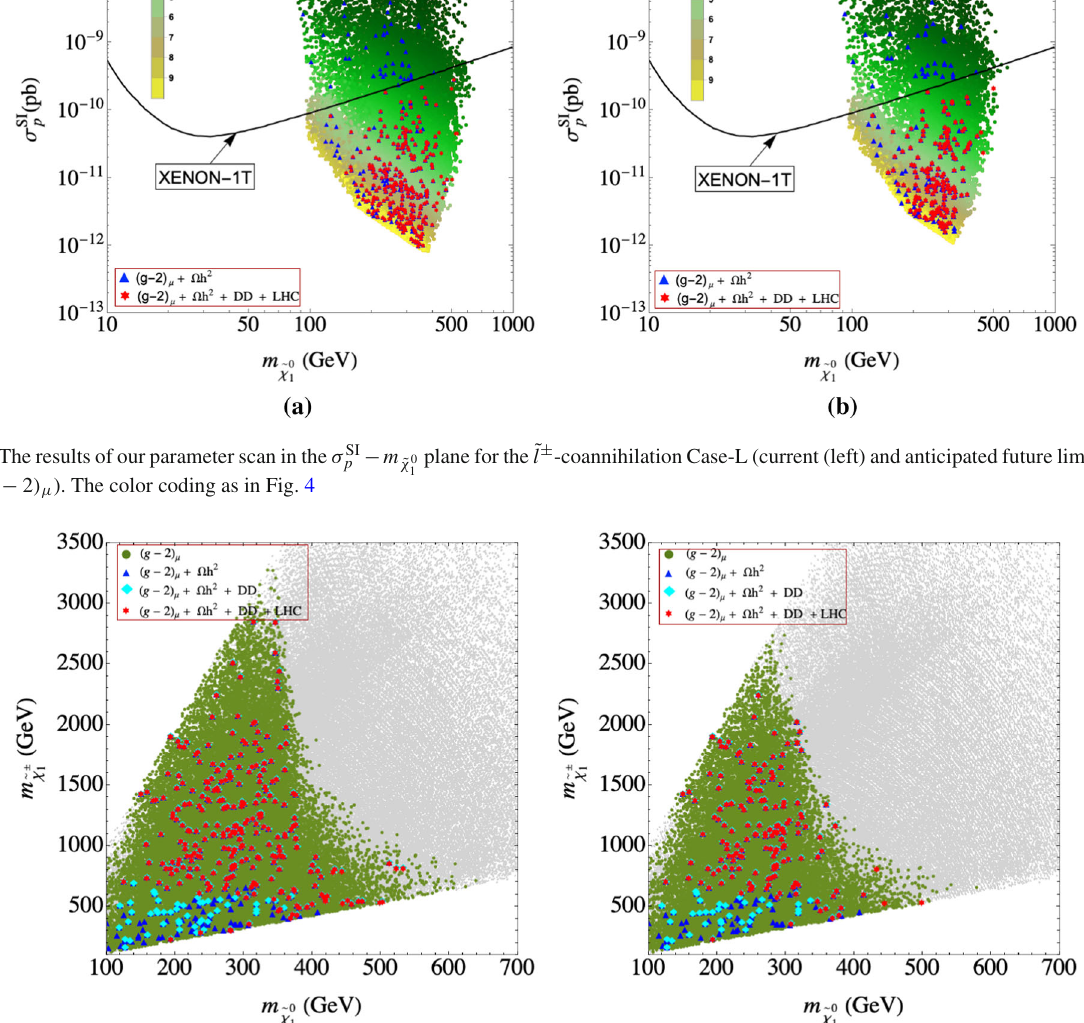
Fig. 9 The results of our parameter scan in the m ˜ χ ± (right) from ( g − 2 ) μ ). The color coding as in Fig.